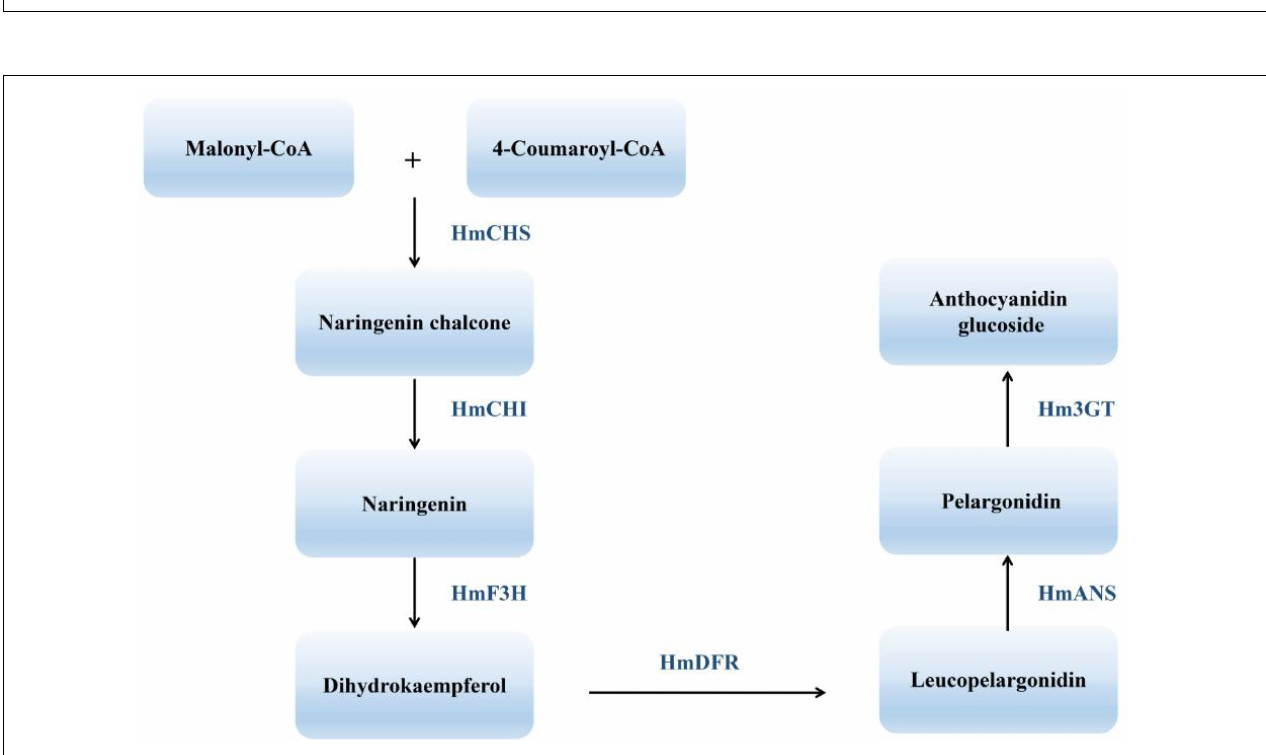
FIGURE 2 | An abbreviated diagram of the flavonoid pathway that produces anthocyanins. CHS, chalcone synthase; CHI, chalcone isomerase; F3H, flavanone 3-hydroxylase; DFR, dihydroflavonol 4-reductase; ANS, anthocyanidin synthase; 3GT, 3-O-glucosyl transferase.